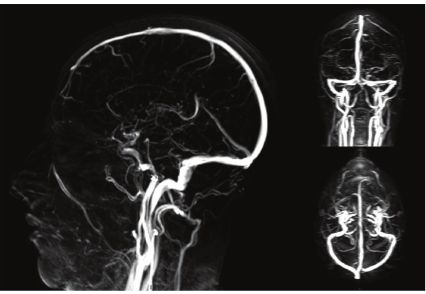
Figure 1: MIP sagittal, coronal, and axial reconstructions of intra- cranial 3D phase contrast